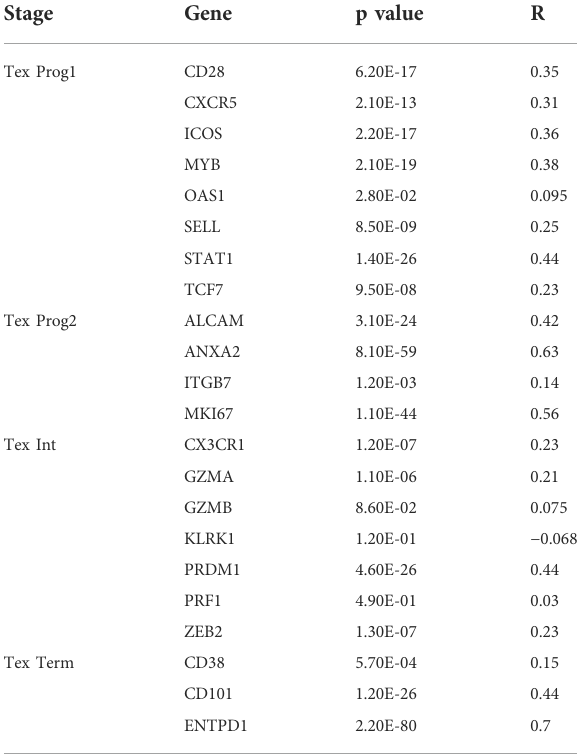
TABLE 4 The correlation between RAB6B expression and major genes of various stages of T cell exhaustion.